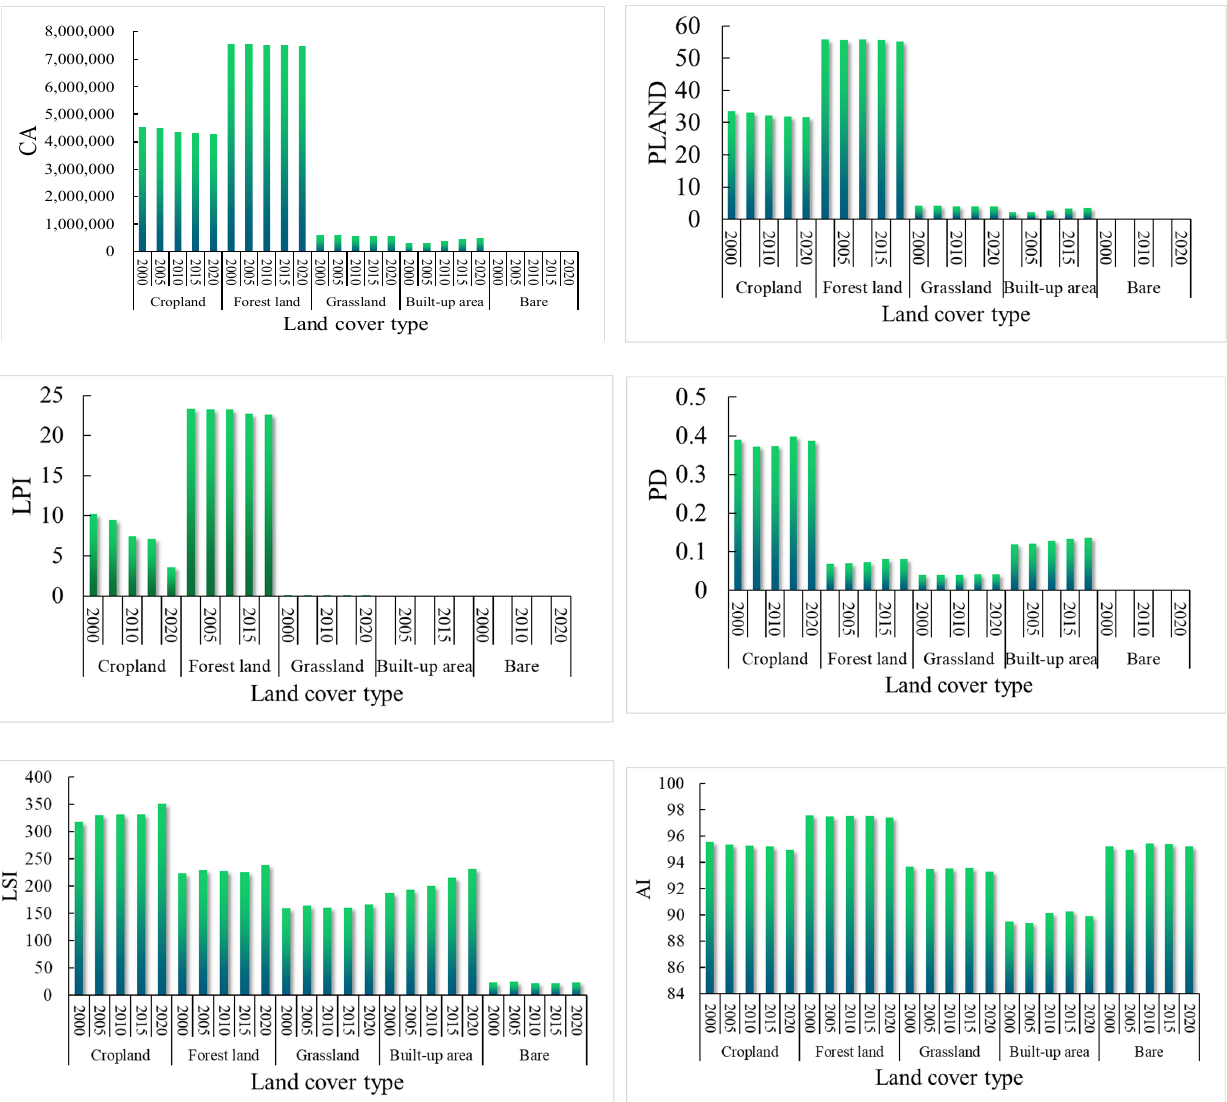
Figure 12. Landscape pattern index analysis for cropland, forestland, grassland, water bodies, bare land (CA—Class area; PLAND—Percent of landscape; LPI—Largest patch index; PD—Patch density; ED—Edge density; LSI—Landscape shape index; AI—Agglomeration index).